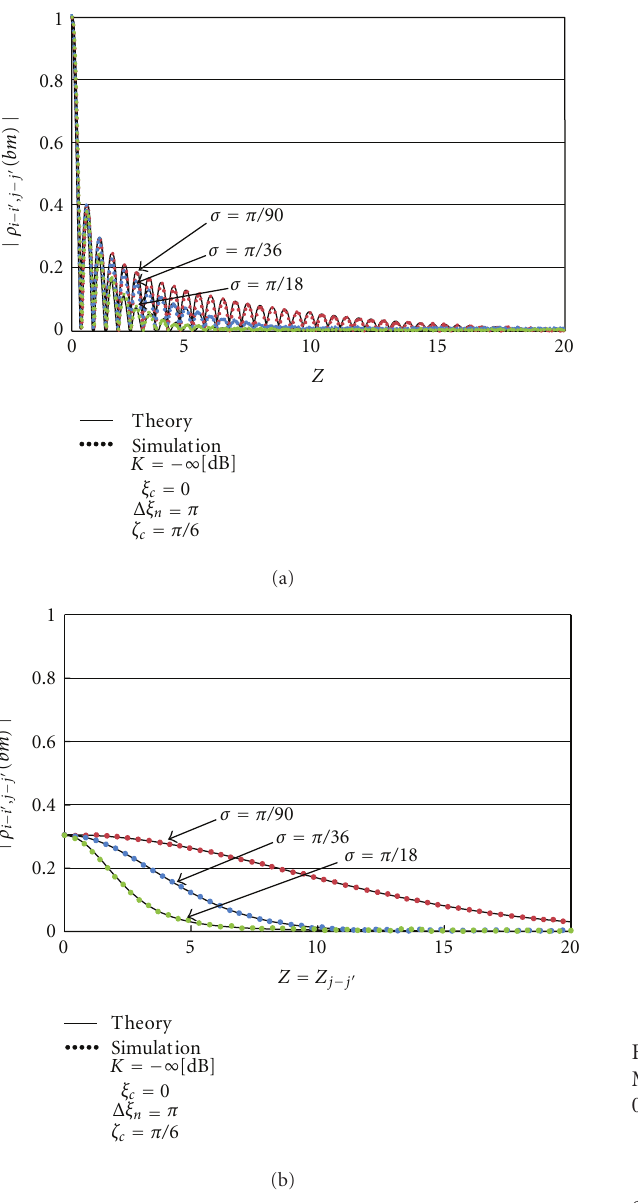
Figure 6: Correlation of both-side channel (uniform-Gaussian distribution). (a) Z = Z i − i (cid:2) = Z j − j (cid:2) . (b) Z i − i (cid:2) = 0 . 5.